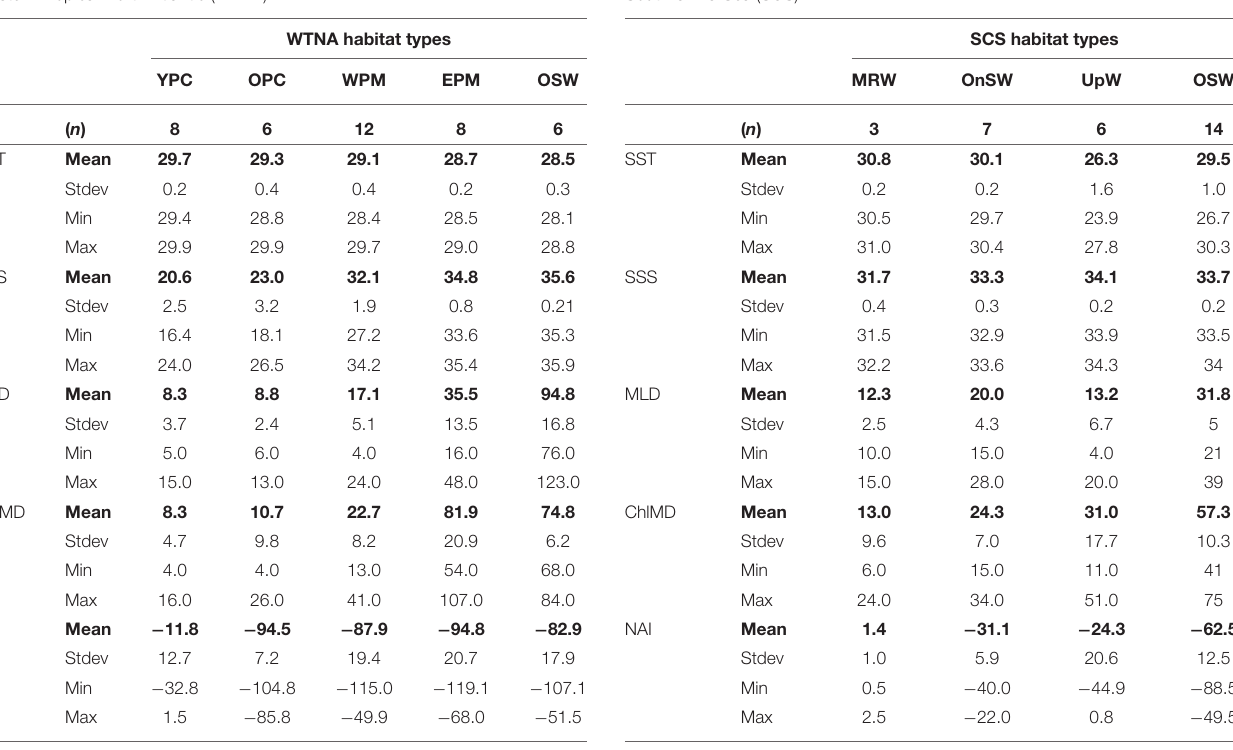
TABLE 2 | Summary of environmental variables used to define habitat types in the South China Sea (SCS).